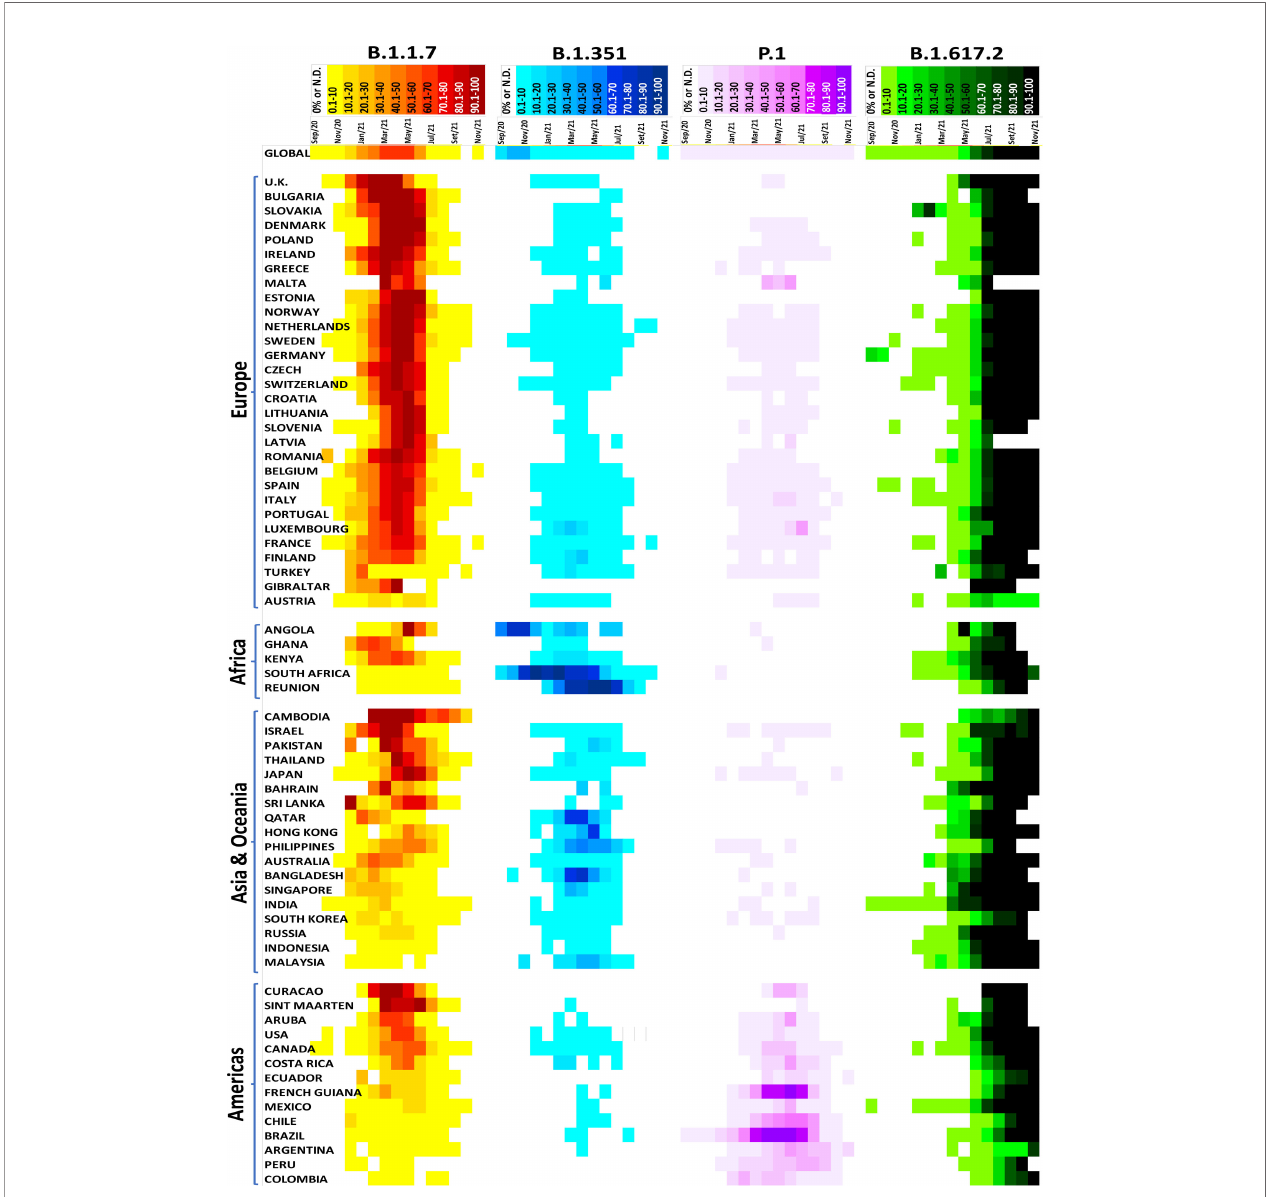
FIGURE 4 | Distribution of the SARS-CoV-2 variants of concern in several countries. Data were analyzed from GISAID from September 2020 to November 2021